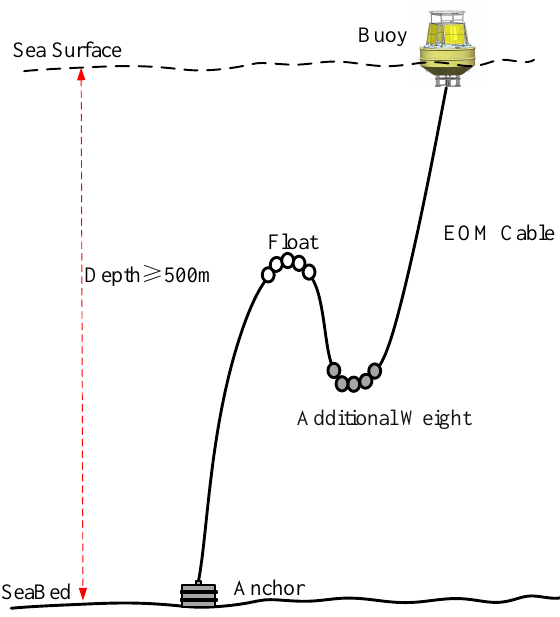
Figure 3. Inverse-catenary mooring.